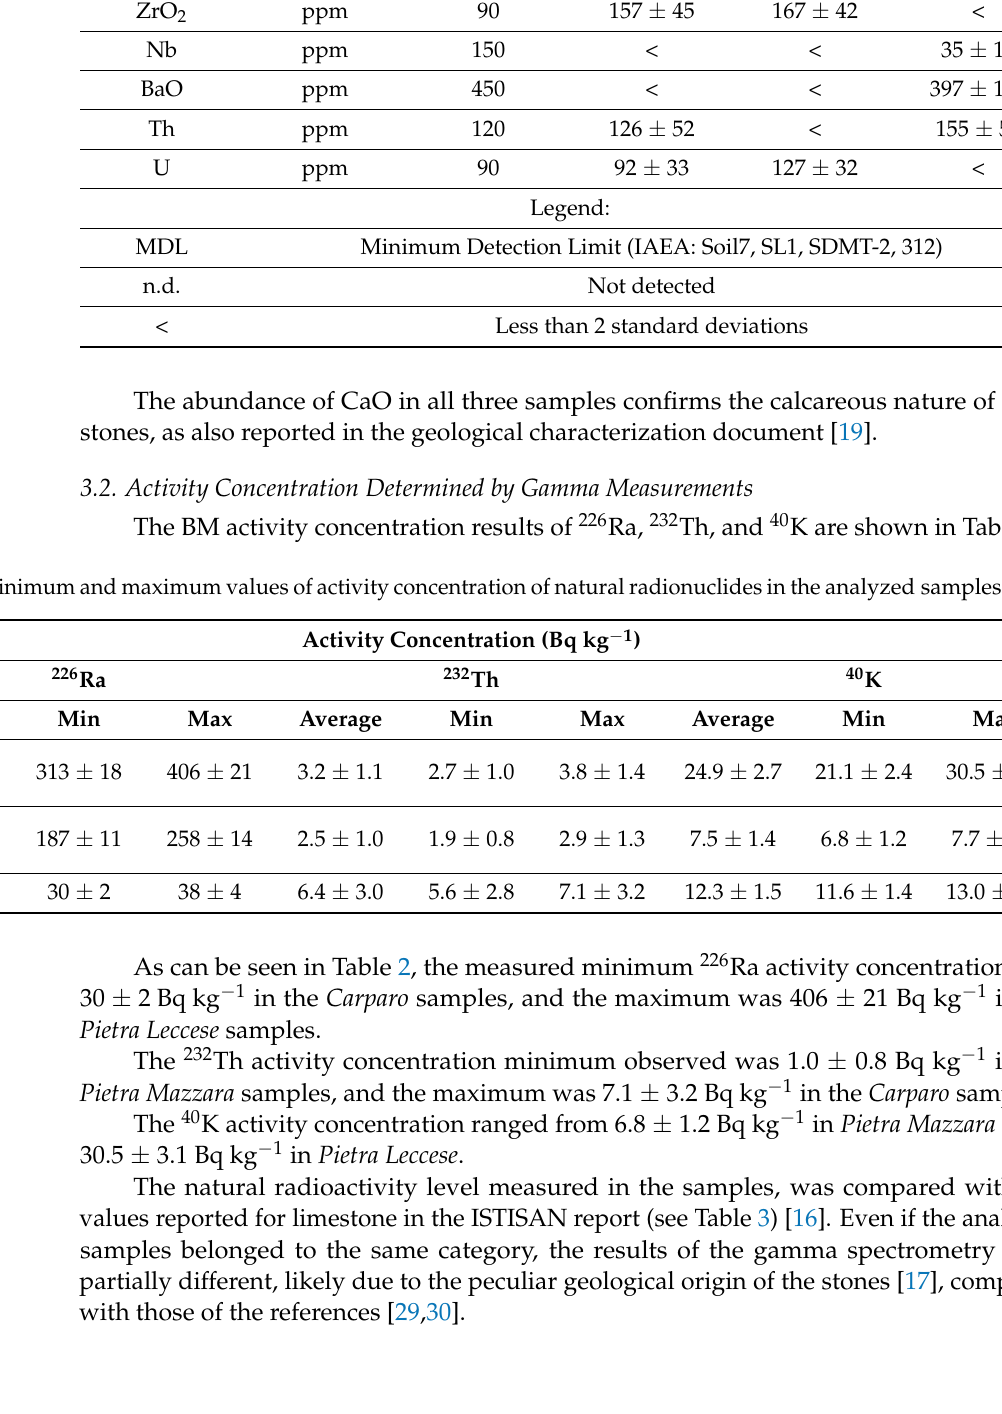
MDL Minimum Detection Limit (IAEA: Soil7, SL1, SDMT-2, 312)